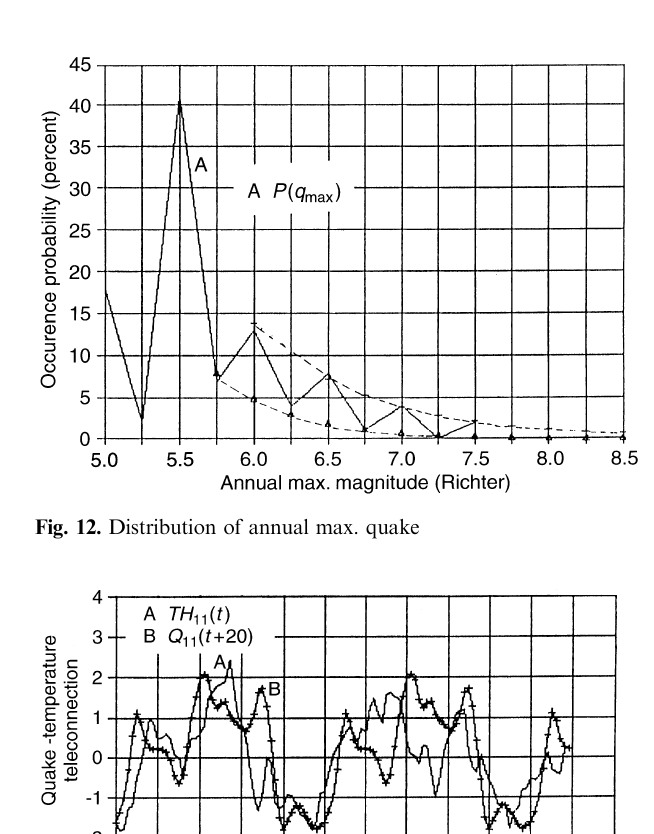
Fig. 11. Seismicity index projection